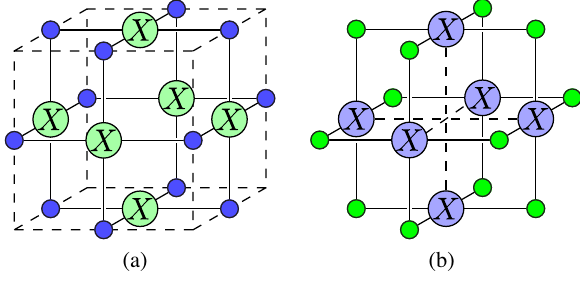
FIG. 2. Generators of the 1-form symmetry in the bulk. (a) A primal generator S . (b) A dual generator S . Thick lines denote q v neighbor relations, and dashed lines denote the cubic